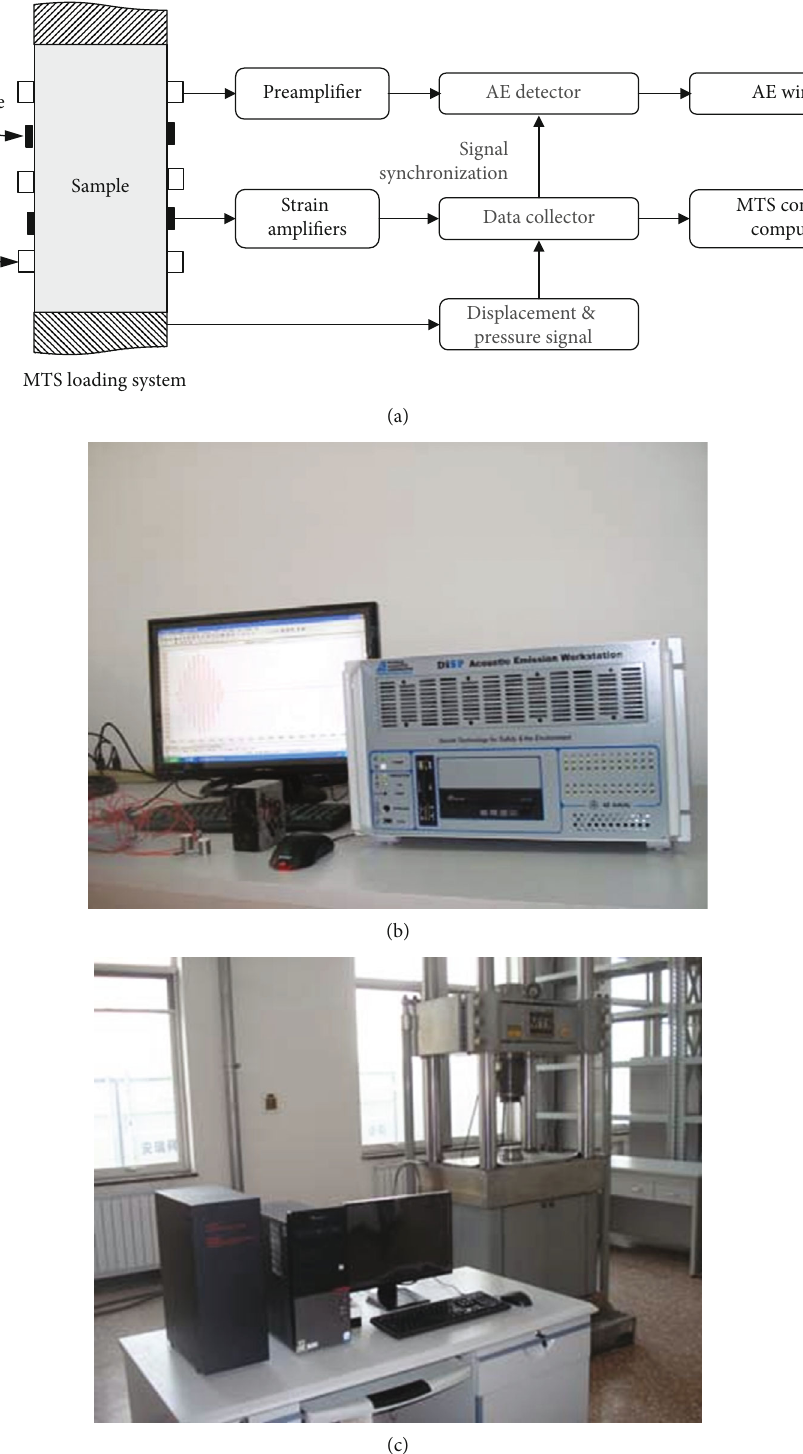
Figure 4: Schematic diagram of the test system of AE mechanics: (a) schematic diagram of the MTS-PCI-2 system; (b) PCI-2 AE system; (c) MTS loading